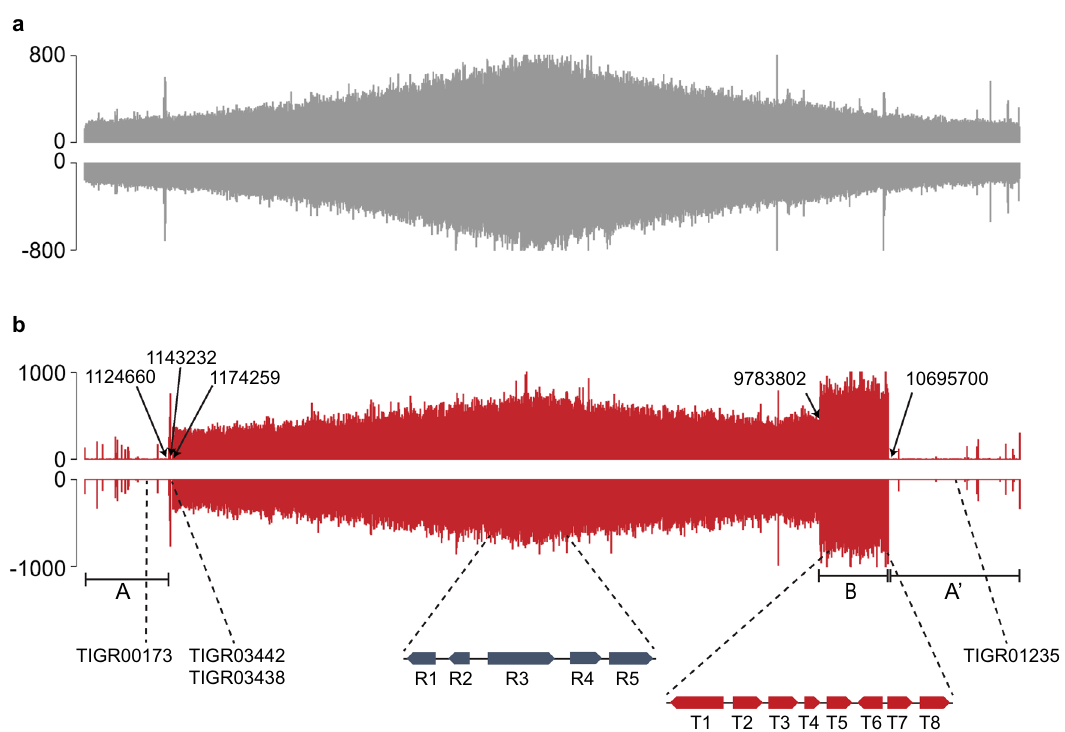
Figure 2. Profiles of Illumina reads from S. rapamycinicus NRRL 5491 (wild-type) and the SRMK07 strain, mapped on the wild-type’s genome assembled in this study. ( a ) Profile of Illumina reads from the wild-type. ( b ) Profile of Illumina reads from the SRMK07 strain. The data were visualized using SignalMap (Roche NimbleGen, Inc., Pleasanton, CA). ‘A’ and ‘A’’ indicate the potentially deleted regions, and ‘B’ indicates the potentially duplicated region in the SRMK07 strain’s genome. Information with dashed lines correspond to the location of target genes for the relative quantification analysis using qPCR (Fig. 3) as well as the deleted core genes (Table 2) in the SRMK07 strain’s